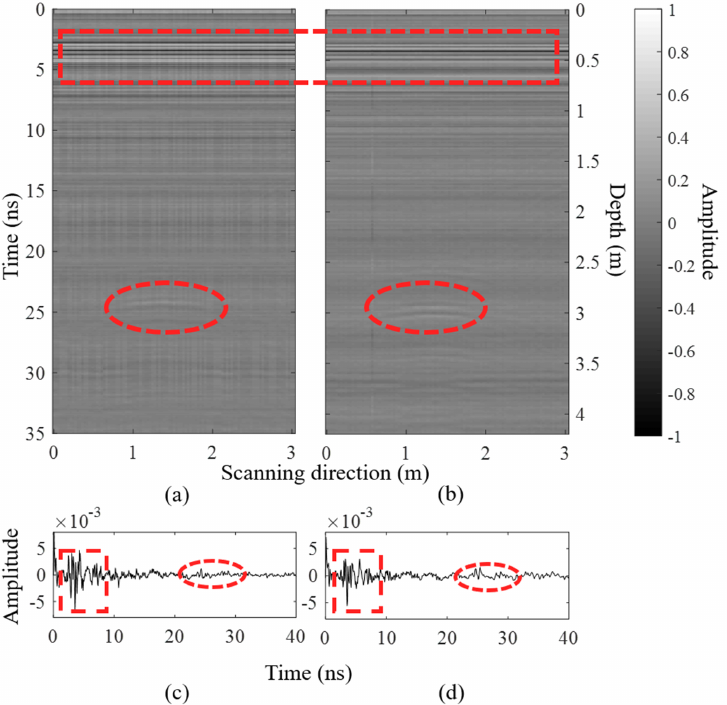
Figure 13. GPR B-Scan images for the transceiver antenna ( a ) without the MMA and ( b ) with the MMA. The return signal for the transceiver antenna ( c ) without the MMA and ( d ) with the